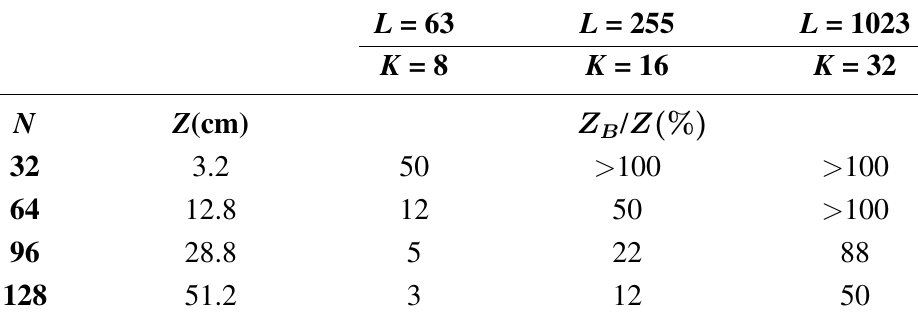
. Kasami B = 3 MHz, c = 1 c